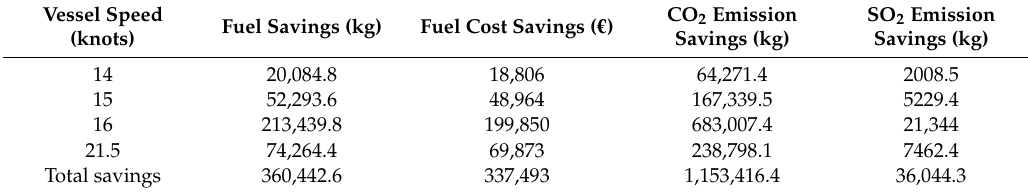
Table 3. Results for fuel savings, fuel cost savings, CO 2 emission savings, and SO 2 emission savings due to the previously mentioned 4000 hrs. mission analysis of the general support